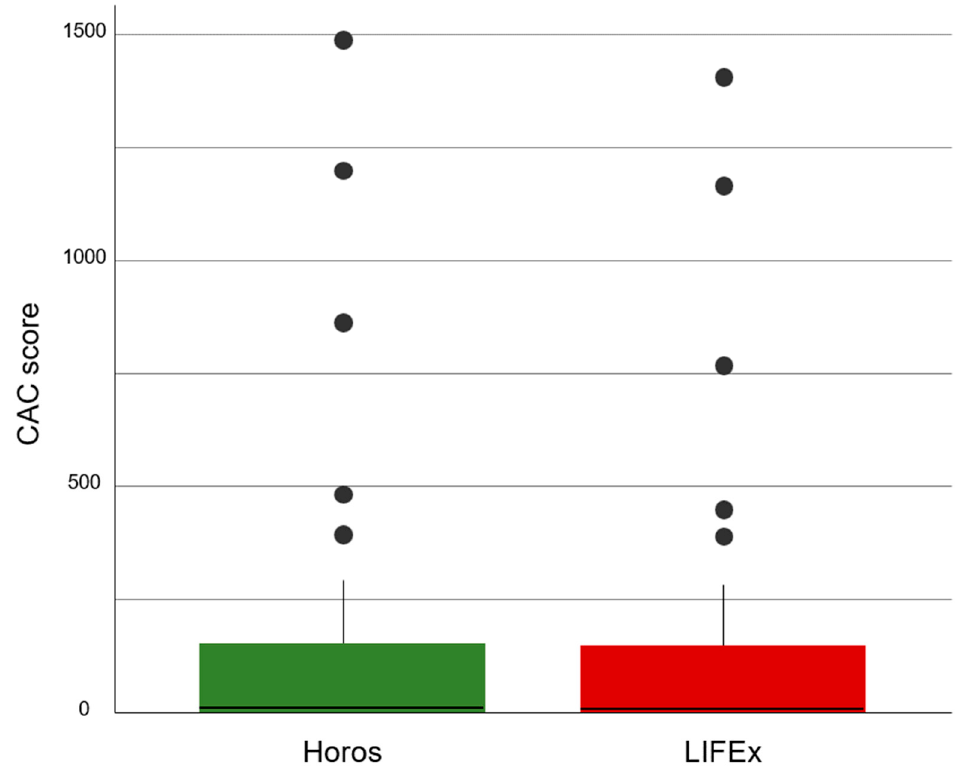
Figure 2. Boxplots of the CAC score values calculated by Horos and LIFEx. The continuous line represents the median, the colored zones delimit the interquartile range, and the filled circles indicate outliers.